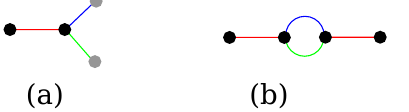
Figure 3: Black and gray dots correspond to the partition into O M